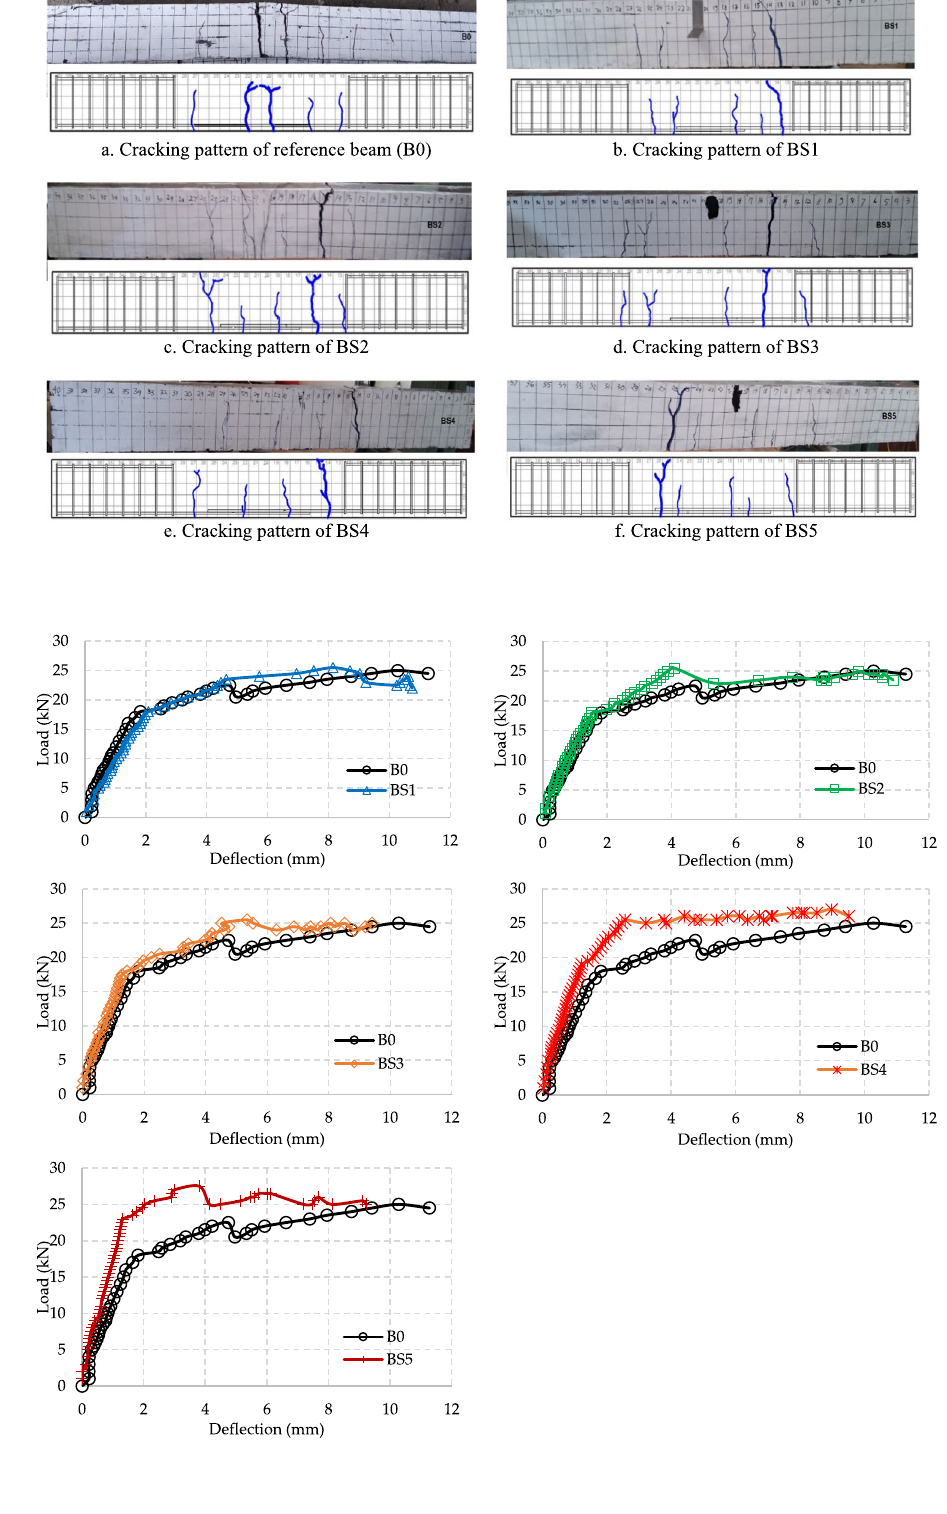
Fig. 3 Final cracking pattern of beam with continuous reinforcement (B0) and spliced reinforcements (BS1–BS5)